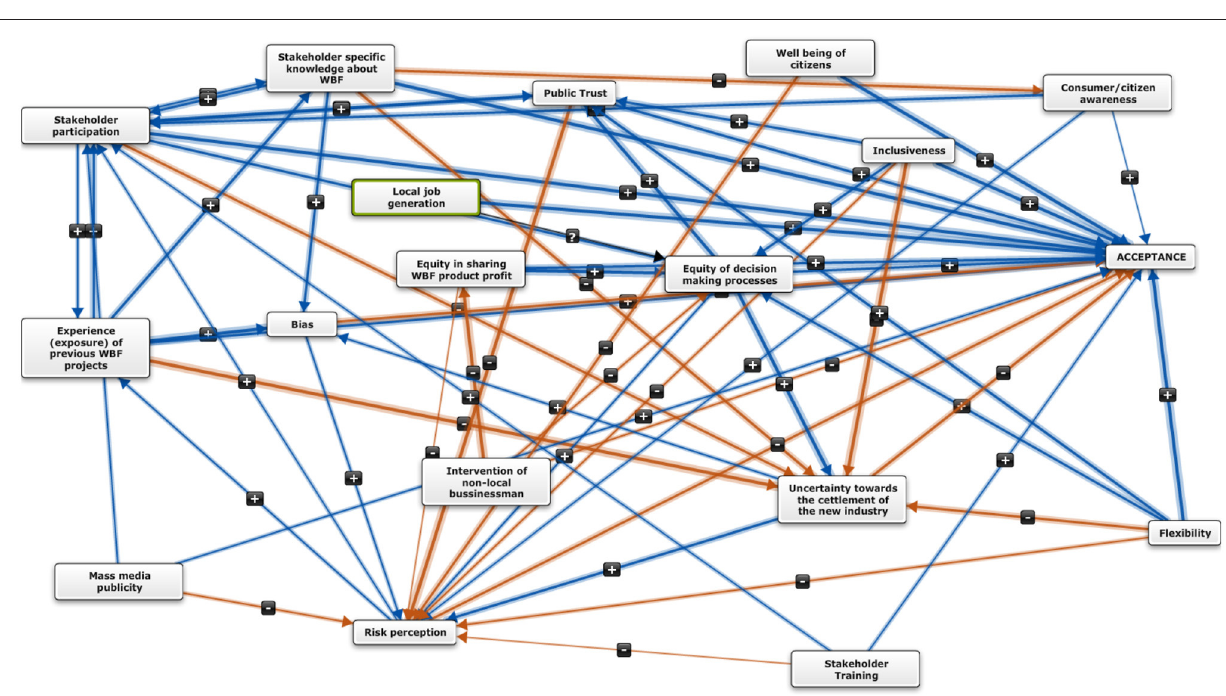
FIGURE 5 | The FCM emanating from only the social aspects affecting acceptance of